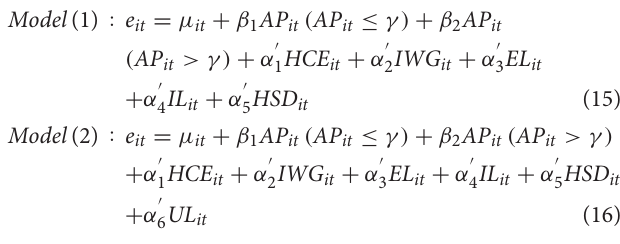
Table 8 indicates that there is still a single threshold effect in western China for different empirical models. The robustness test shows that the previous test between the two indexes is obvious in the western region even if different control